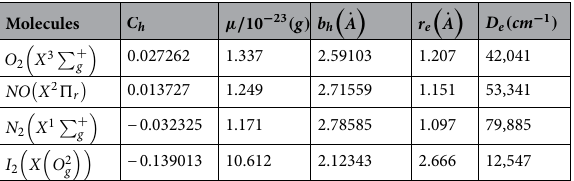
Table 1. Model parameters for diatomic molecules used in this work 13 .